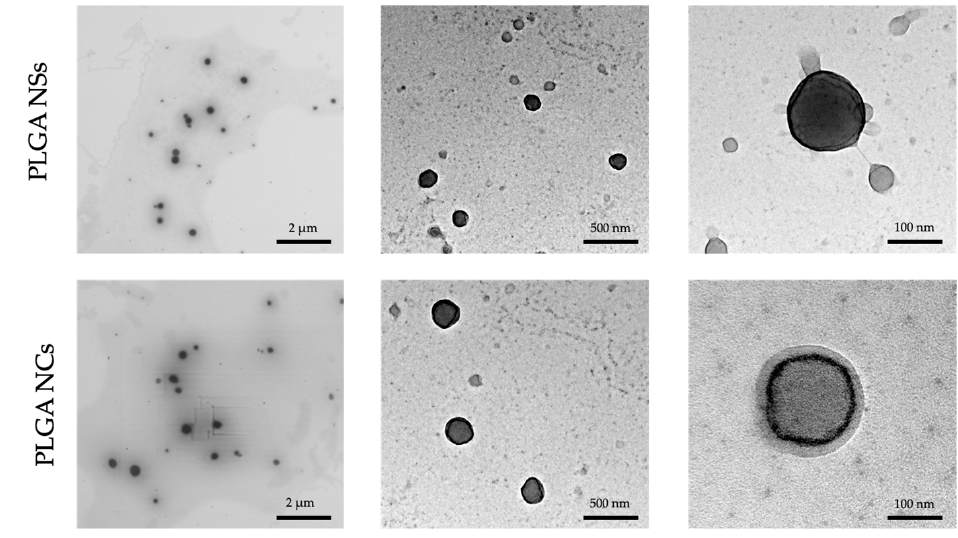
Figure 4. TEM images of lactoferrin-loaded PLGA NSs and lactoferrin-loaded PLGA NCs.